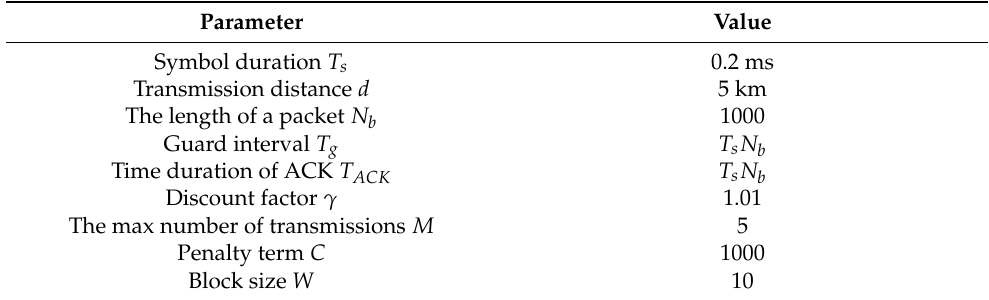
Table 1. Simulation